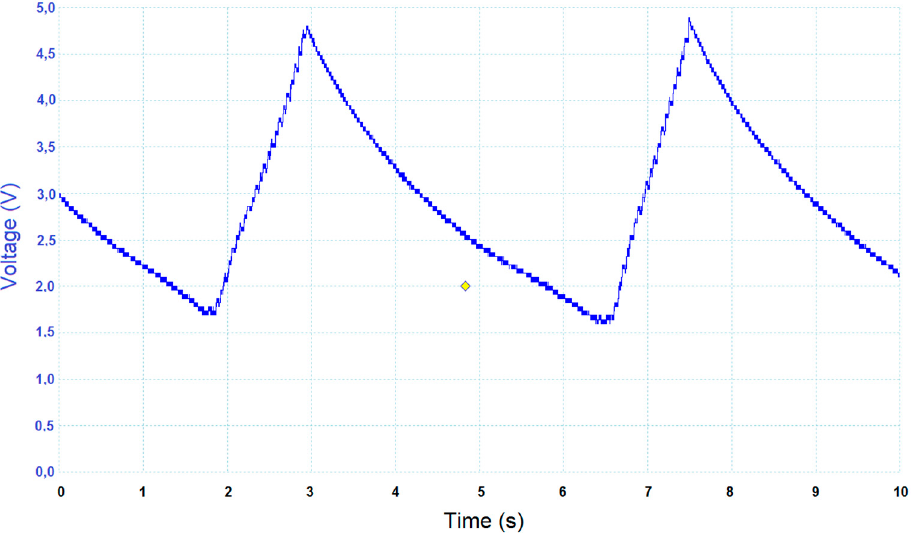
Figure 15. (cid:1848) (cid:1853)(cid:1873)(cid:1876) behavior in a real case with wind speed of 3.5 m/s. The duration of the charge– discharge cycle is about 5 s.